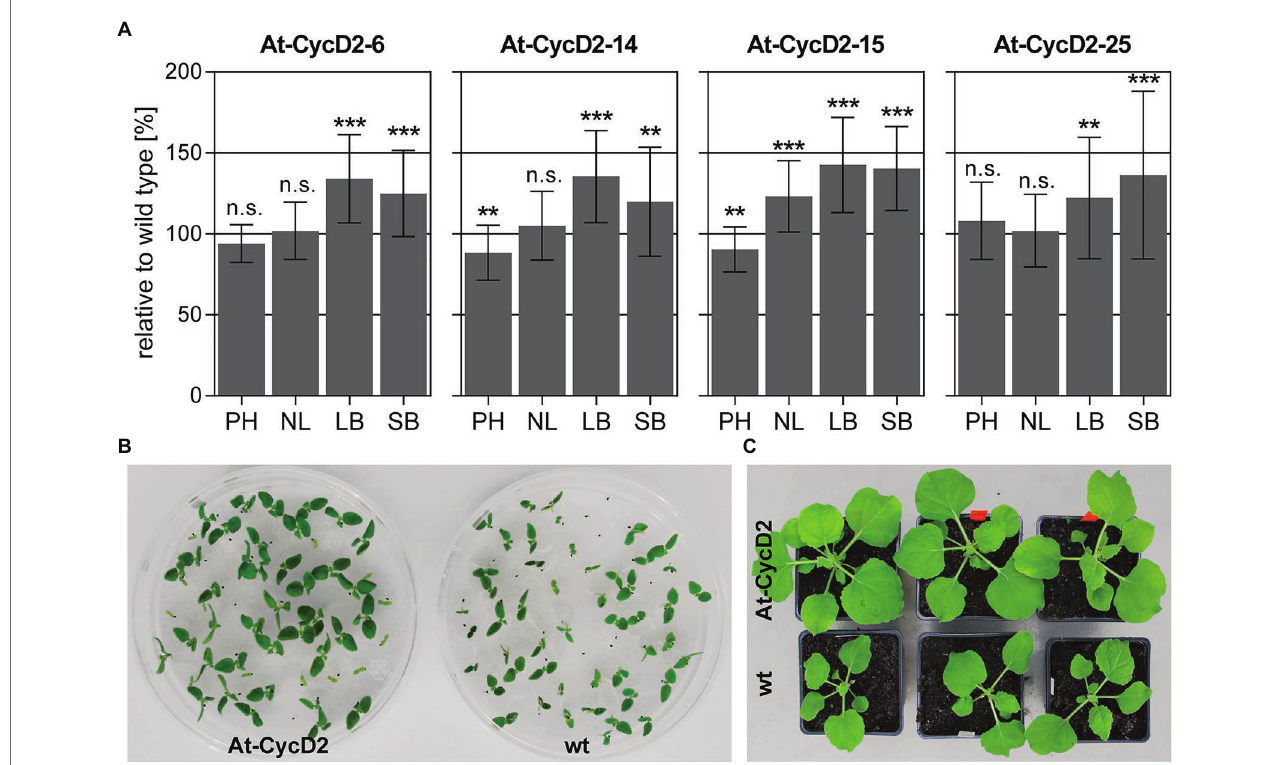
FIGURE 2 | Phenotypic characterization of transgenic N. benthamiana lines expressing the At-CycD2 gene. (A) Evaluation of plant height (PH), number of leaves (NL), leaf biomass (LB) and stem biomass (SB). Non-transgenic and T 1 progeny of At-CycD2-6, At-CycD2-14, At-CycD2-15, and At-CycD2-25 transgenic plants were grown in greenhouse for 4 weeks and assayed for the plant height, number of leaves and above ground biomass characteristics. The phenotypic parameters are expressed as a percent relative to the wild type. Values represent the means with standard deviation ( n = 45). Asterisks indicate significance as determined by the unpaired T-test, with ** and *** denoting p < 0.01 and p < 0.001, respectively. Not significant values are determined as ns. Non-transgenic and transgenic At- CycD2-15 plants grown in vitro (B) and in soil (C) . At-CycD2-15 and wild type N. benthamiana seeds were germinated in vitro on selective (5 mg/L PPT) and non- selective MS medium, respectively, and photographed at 12 days after sowing. The soil-grown plants were photographed at 21 days after